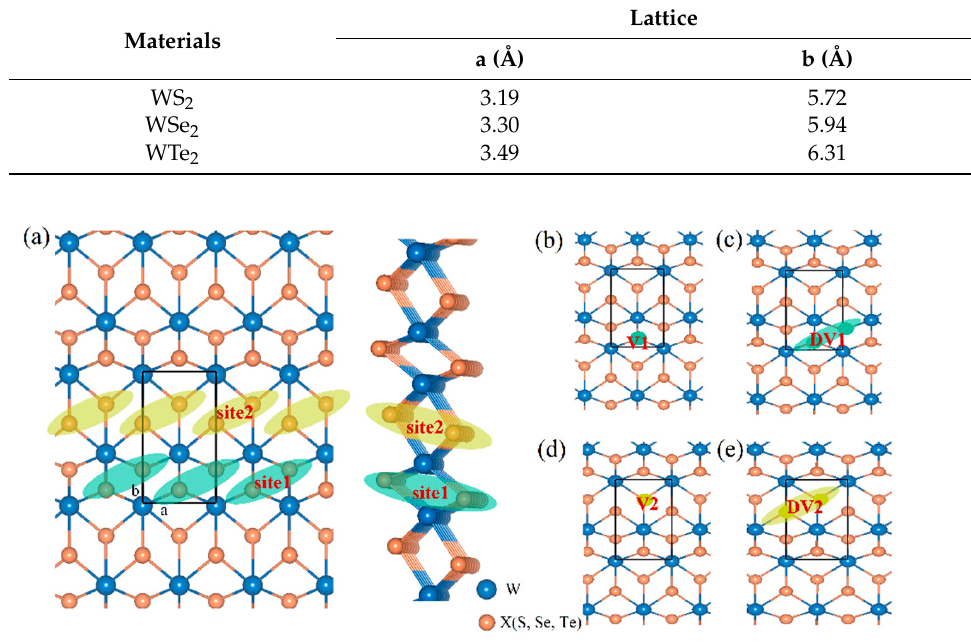
Figure 1. Crystal structure of the T’-WX 2 (X = S, Se, and Te) monolayer with ( a ) a pristine structure, ( b ) the single vacancy of X at site 1 (V1), ( c ) the double vacancy of X at site 1 (DV1), ( d ) the single vacancy of X at site 2 (V2), and ( e ) the double vacancy of X at site 2 (DV2).